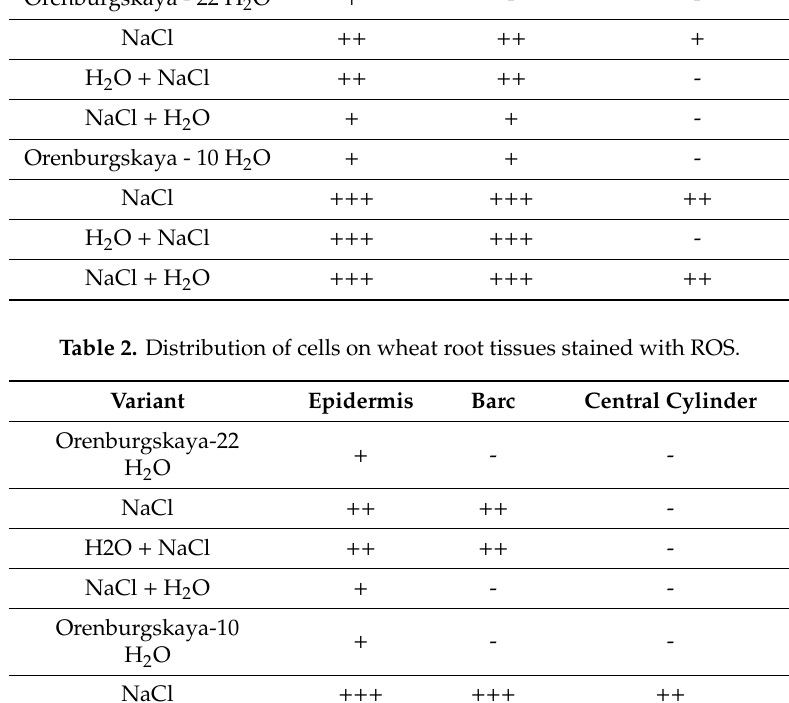
Table 1. Distribution of wheat cells from the division zone to the stretching zone stained with ROS. Variant Cap Division Zone Stretch Zone